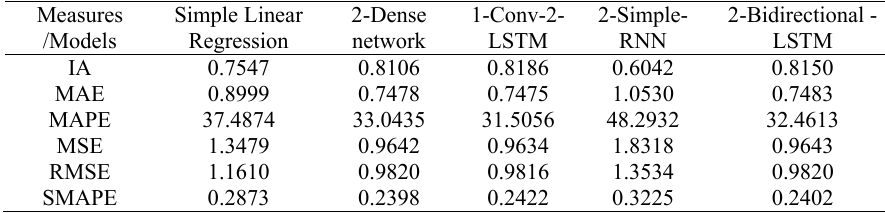
Table 6. Performance evaluation measures for different models on Salem station